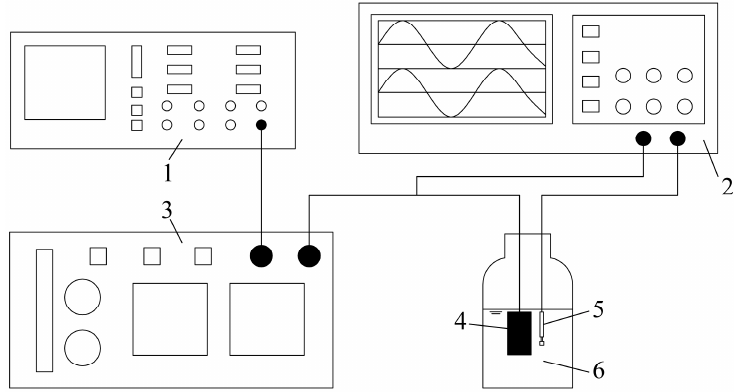
Figure 1. Experimental ultrasonic devices. 1. Signal generator; 2. Oscilloscope; 3. Power amplifier and matching circuit; 4. Transducer; 5. Hydrophone; 6. Algal liquid.